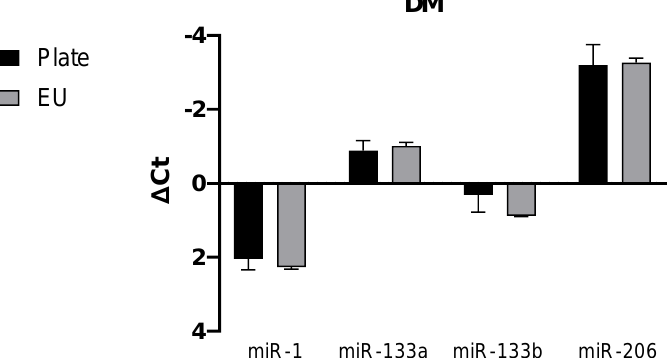
miR-133a, miR-133b and miR-206 in both proliferation (GM) and differentiation (DM) conditions, as Figure 5. MicroRNA expression profile in huMPCs. The graphs show the relative expression of miR-